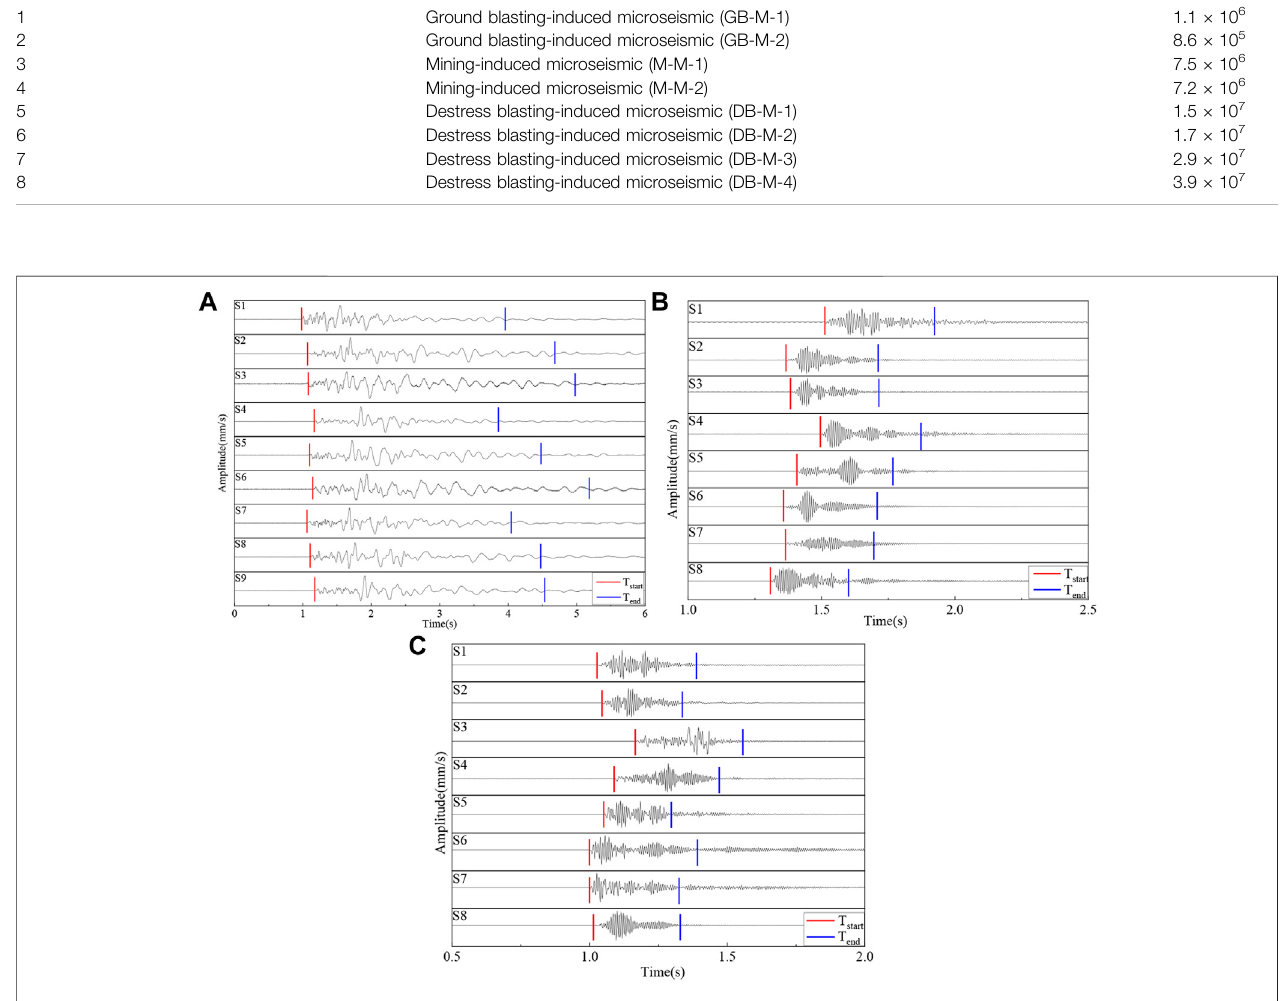
FIGURE 2 | Waveforms of different types of induced microseismic waveforms. (A) Ground blasting-induced microseismic (GB-M-1); (B ) mining-induced microseismic (M-M-1); and (C) destress blasting-induced microseismic (DB-M-1).